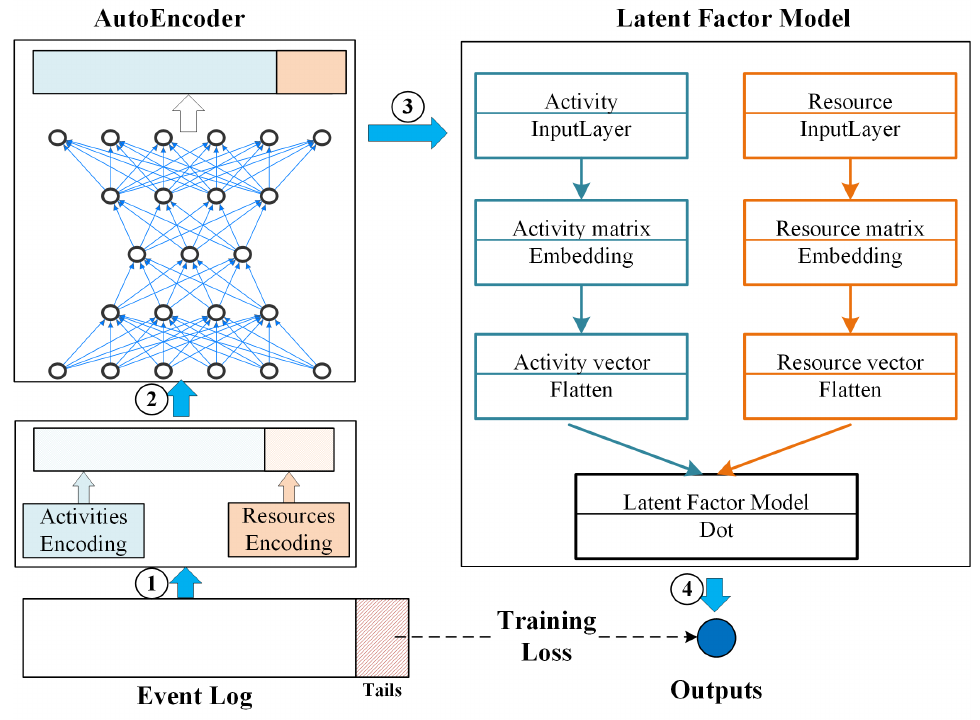
Figure 1. Business Process Outcome Prediction